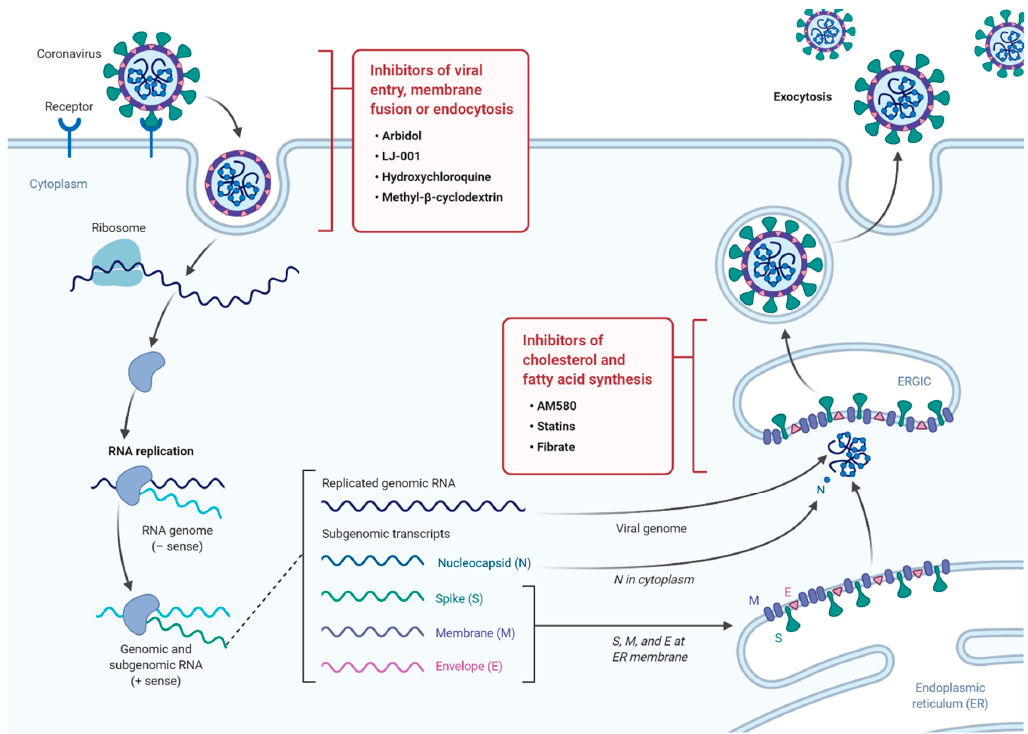
Figure 1. A diagram illustrating the life cycle of SARS-COV2 and potential lipid modifying drugs that can used as broad-spectrum antiviral drugs to inhibit viral entry, membrane fusion, or endocytosis as well as inhibition of fatty acid and cholesterol